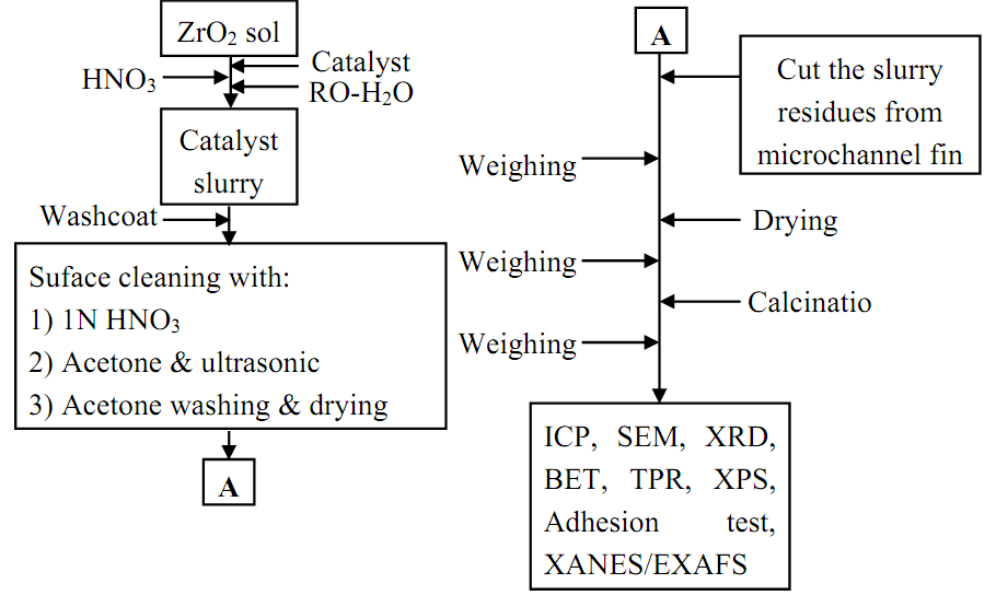
sol for steam reforming of methanol in a 2